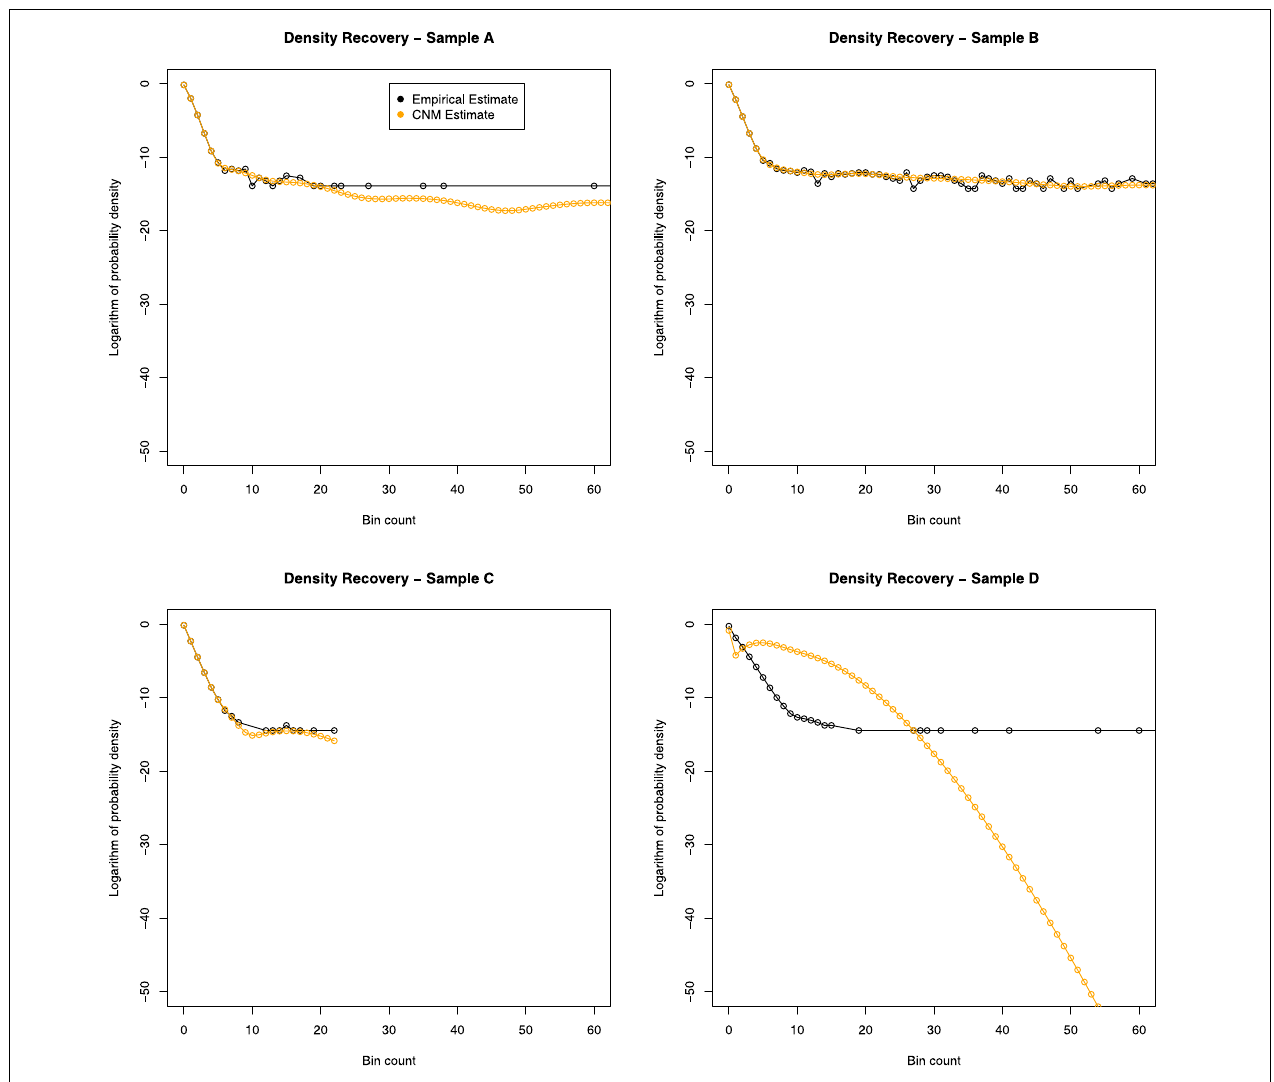
FIGURE 2 | Distribution recovery in each data set. The empirical distribution obtained from the actual data (black line) appears to show a dramatic change in behavior around x = 9. While CNM reported failure to converge for samples C and D, it can be seen that sample C’s distribution was adequately